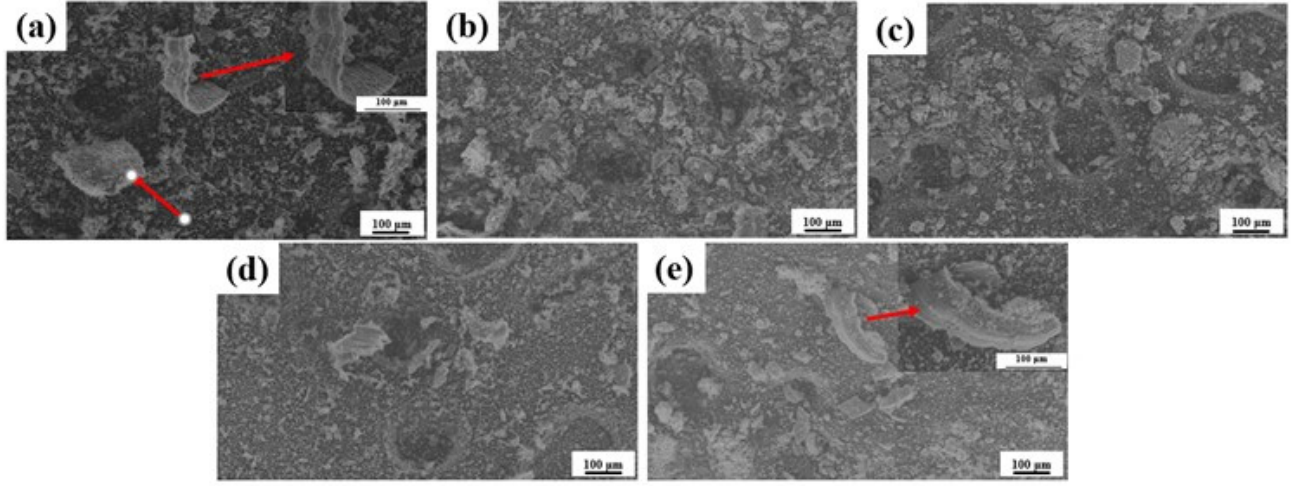
Figure 16. Chips produced in the wear test of coated samples: 0 ( a ), 1 ( b ), 2 ( c ), 3 ( d ), and 4 ( e ) g/L TiO 2 .